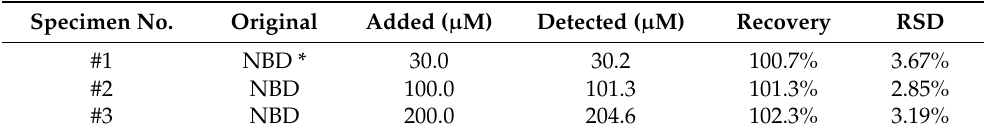
Table 1. Detection data of p-NP sampled from a local river. Specimen No.